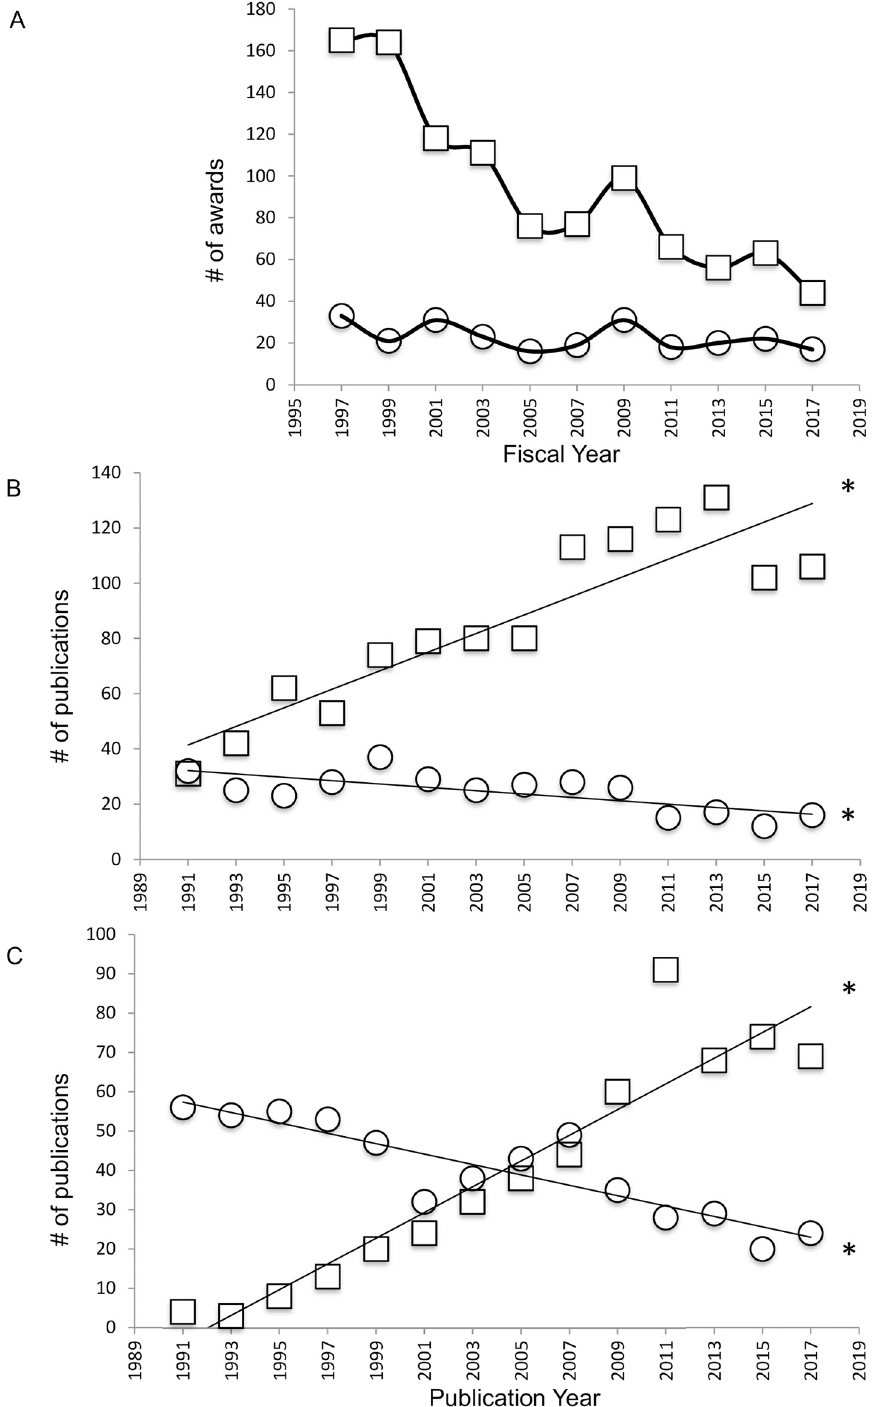
Fig 4. Publications for GMO and EO species within the insects and fish (Chondrichthyes + Osteichthyes). A. NSF neuroethology awards for non-genetic model species research (EOs, squares) and genetic model species research (GMOs, circles) from 1997–2017. B. Curated publications by United States authors using the Drosophila melanogaster model species (squares) and other insect model species (circles). C. Curated publications by US authors using the zebrafish model species (squares), and other fish model species (circles), Asterisks in B indicate significant increase in Drosophila publications (top) and decrease in other insect publications. Asterisks in C indicate significant increase in zebrafish publications (top) and decrease in other fish publications.